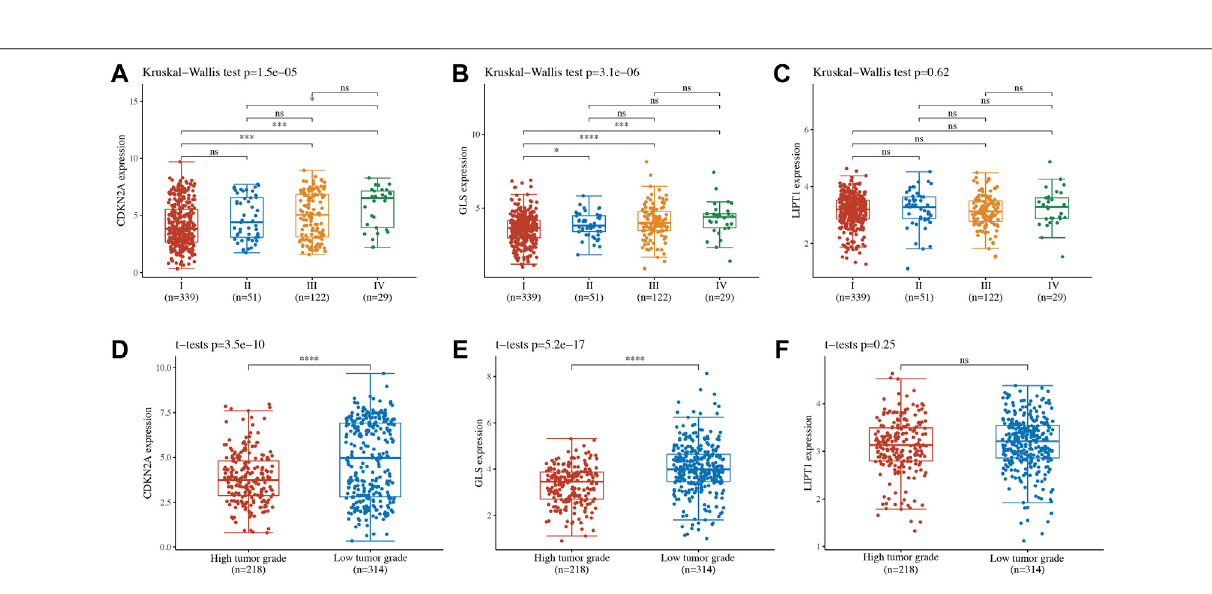
FIGURE 7 | Expression of cuproptosis-related prognostic biomarkers in different groups of uterine corpus endometrial carcinoma (UCEC) patients. (A – C) Expression of CDKN2A, GLS, and LIPT1 in UCEC patients in different pTNM stages. (D – F) Expression of CDKN2A, GLS, and LIPT1 in UCEC patients in different tumor